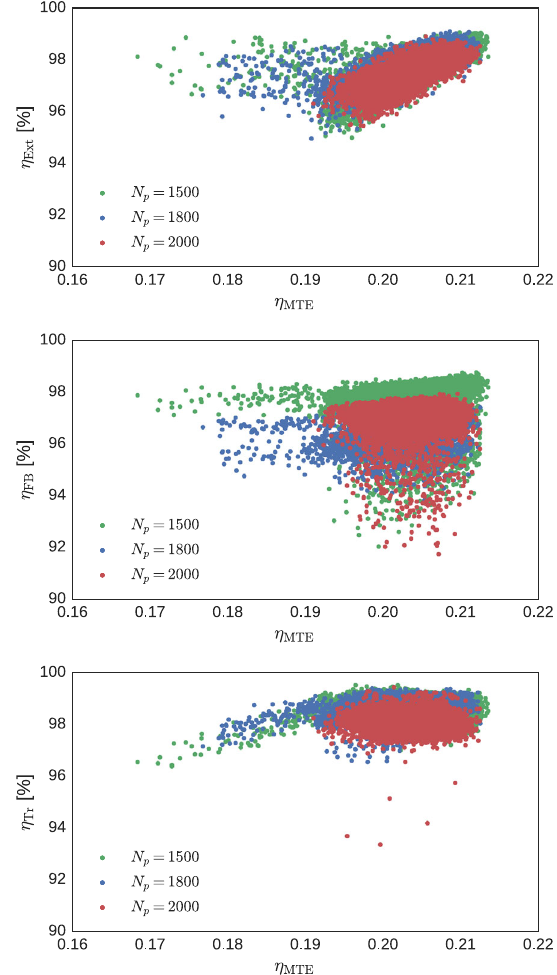
FIG. 19. Example of correlation plots between PS and SPS efficiency figures of merit. The progressively lower correlation between η and transmission efficiencies for later stages in the MTE SPS cycle is clearly visible. The typical intensity values are in units of 10 10 ppp at extraction from the